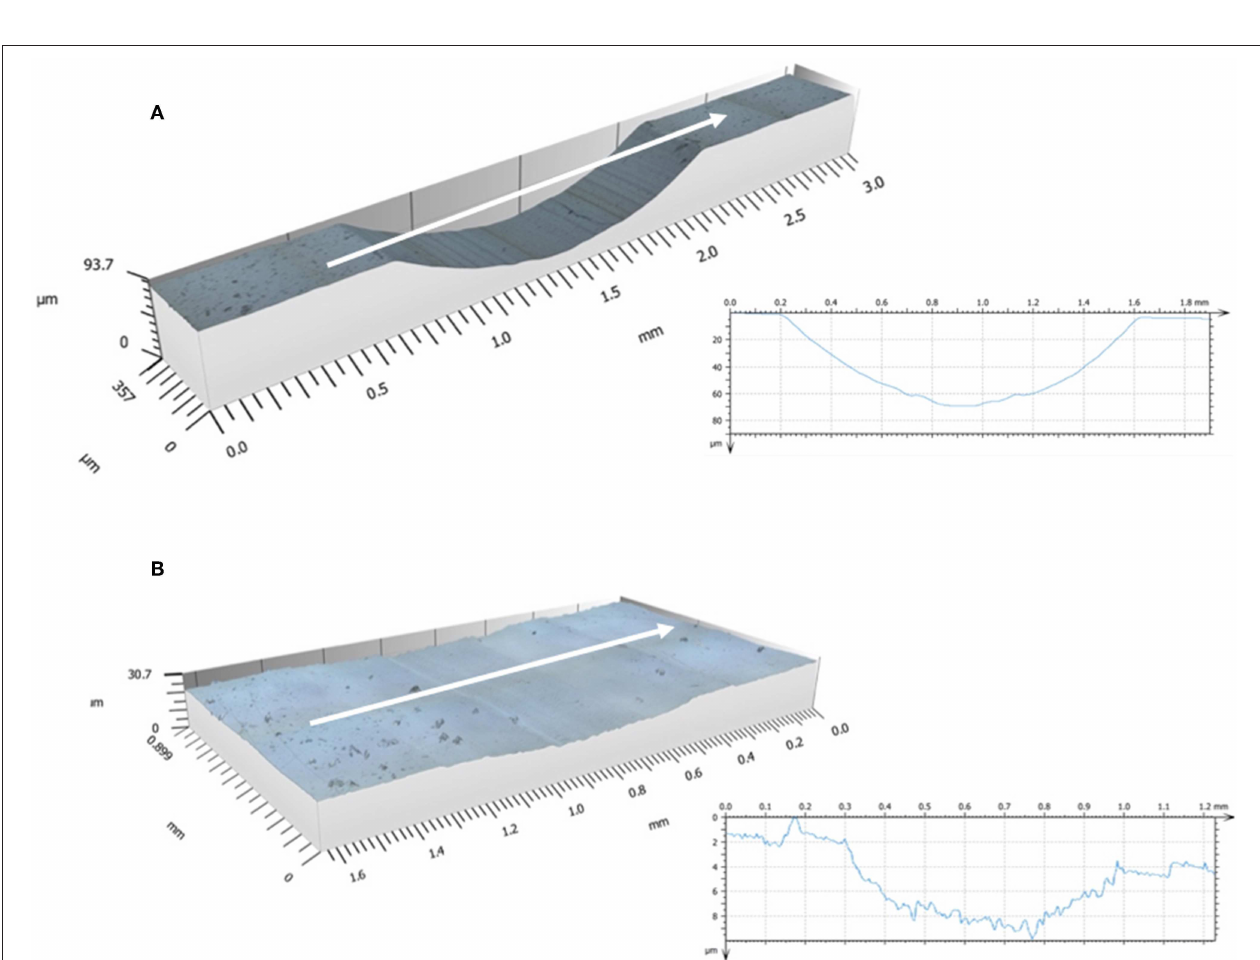
FIGURE 12 | 3D Optical Profilometry micrographs, with cross-lines arrow marked, obtained from the worn track of: (A) Nucrel specimen and cross-line profile (inset) (B) Su/ePLA/Su specimen and cross-line profile (inset).